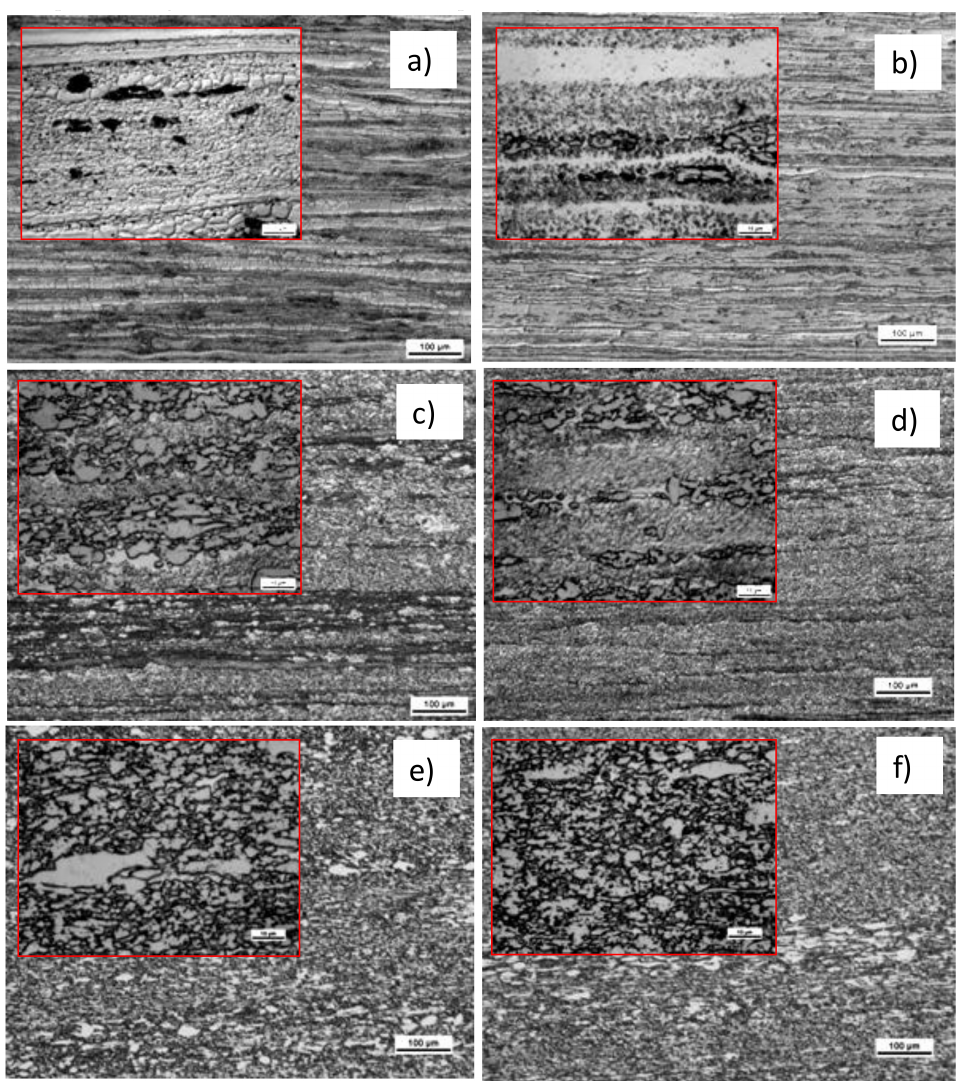
Figure 4. Microstructure of Al–Cu alloys after KoBo deformation: ( a , b ) Al 5 Cu alloy, ( c , d ) Al 25 Cu alloy, ( e , f ) Al 33 Cu alloy, ( a , c , e ) λ = 30, ( b , d , f ) λ =